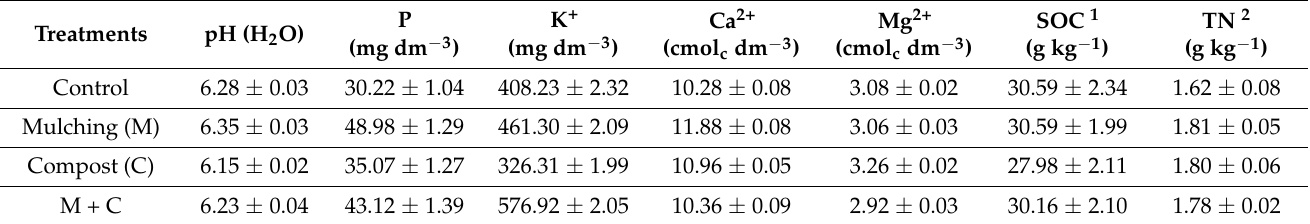
Table 2. Soil chemical properties of before to start the field experiment (mean, n = 192) in a